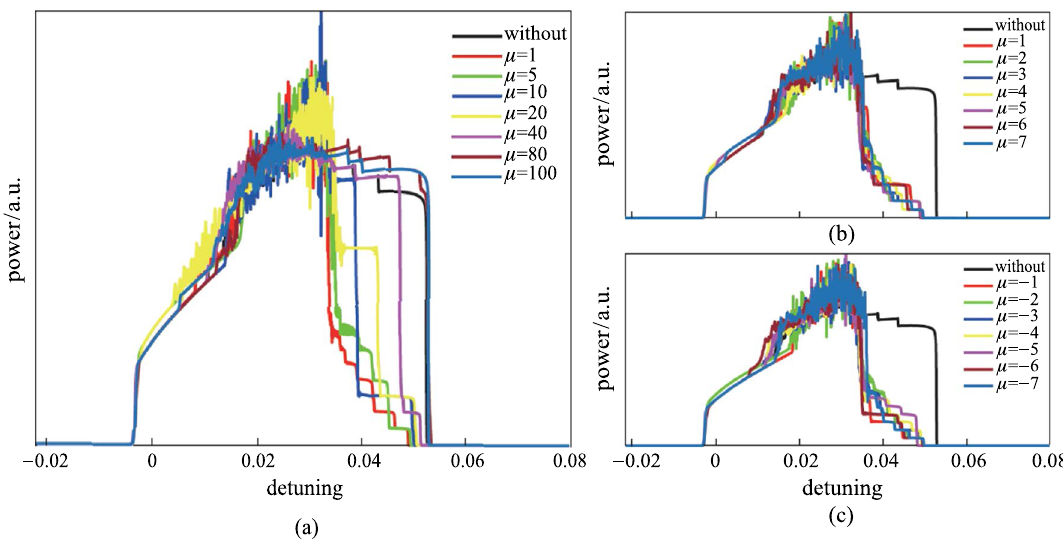
Fig. 3 a Intracavity power traces with respect to δ for different 𝜇 . The pump-resonance detuning 𝛿 ranges from − 0.022 to 0.08. The black solid line is the curve for a micro-ring resonator without the coupled filter. b and c Are the intracavity power as a function of 𝛿 for positive and nega- tive value of 𝜇 , which means central frequency of the filter is located at the blue side or red side of the pump frequency. Simulation parameters are the same as in Fig.